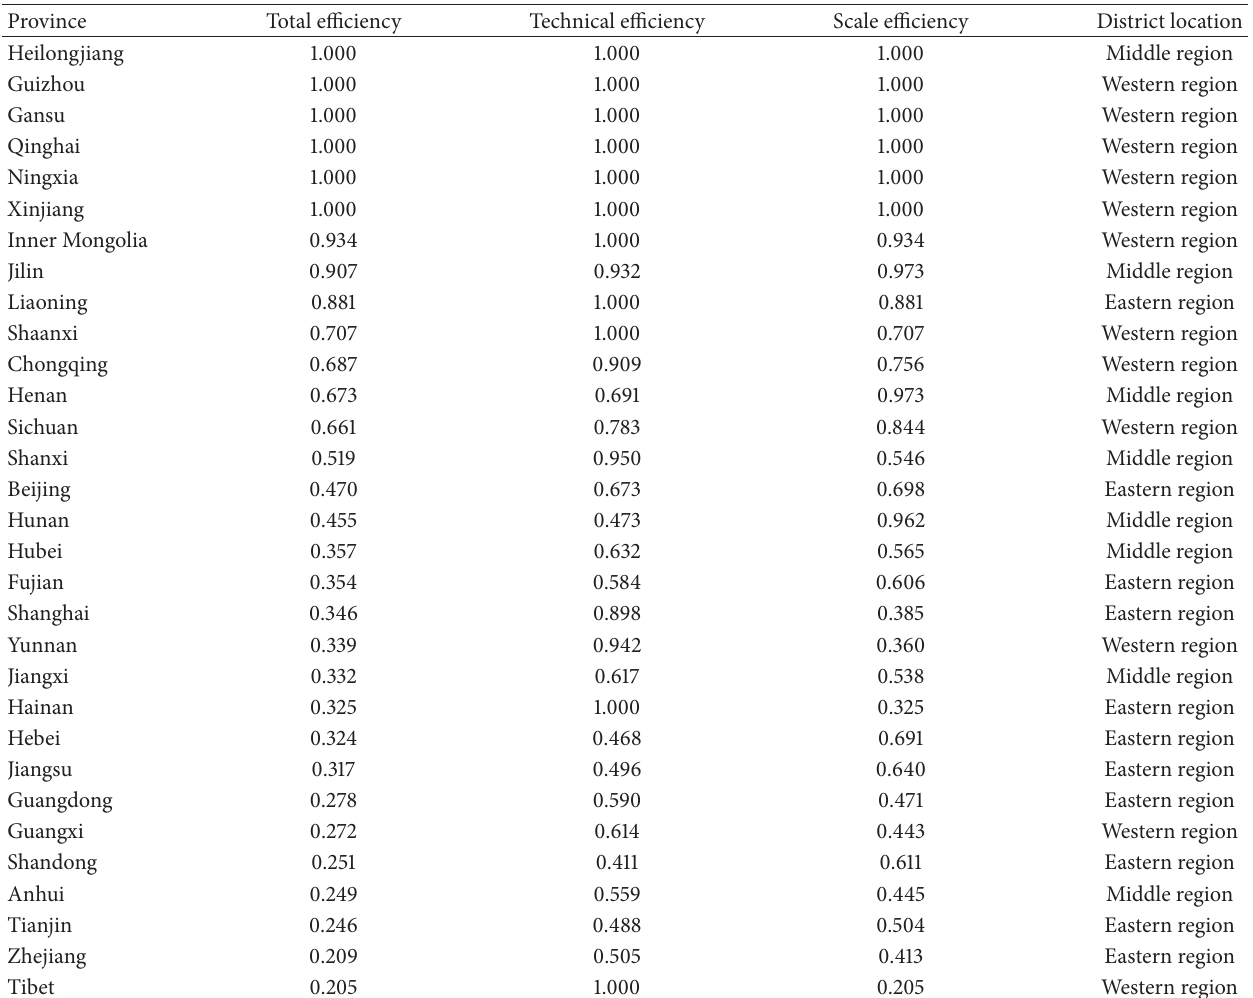
Table 4: Ecoefficiency of intensive agricultural production in China.